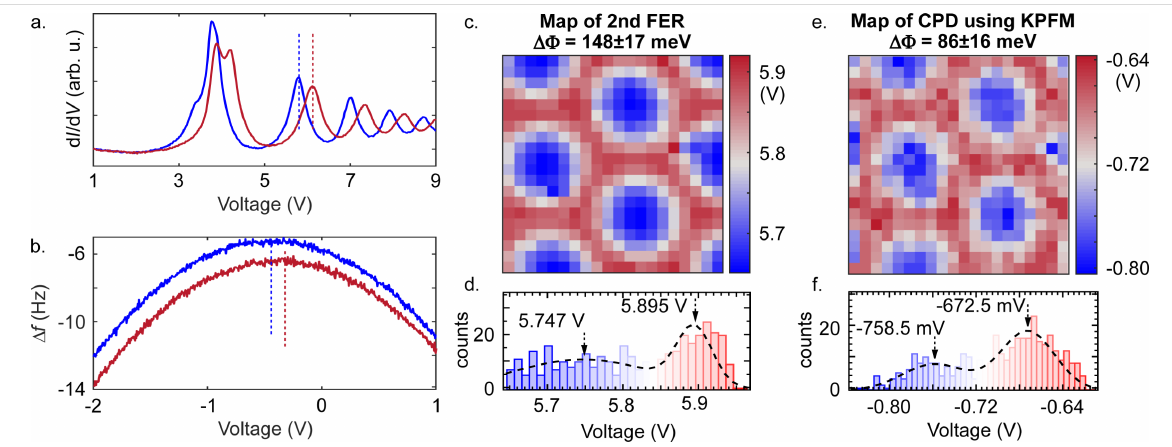
Figure 3: Work function variation between rim (red) and valley (blue) areas measured using (a.) d I /d V at constant current ( I = 100 pA) and (b.) KPFM at constant height (stabilised in the valley at I = 100 pA, V = 10 mV, A osc = 50 pm), respectively. The dotted vertical lines mark exemplary FER and CPD values used for the spatially resolved plots shown in (c.) and (e.). The maps are recorded at the yellow box indicated in Figure 2c on a 20 × 20 grid over 20 × 20 nm 2 . They display the position of the maximum of the second peak in the FER (c.) and the maximum of the KPFM parabola (e.), re- spectively. (d., f.) Histograms and fits for rim and valley where arrows mark the centre positions of the Gaussians used for the determination of the dis- tribution centre.